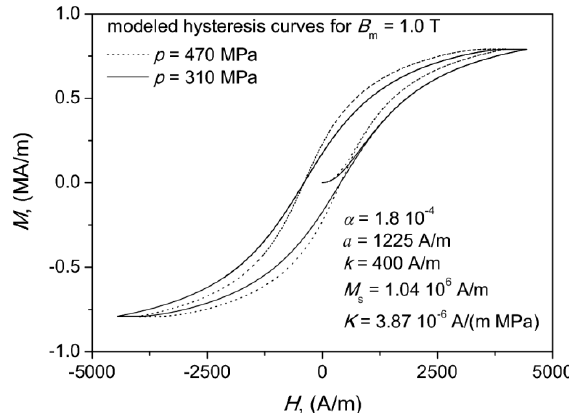
Figure 7. Modeled hysteresis curves for B m = 1.0 T and the estimated set of Jiles–Atherton–Sablik (JAS) model parameters.